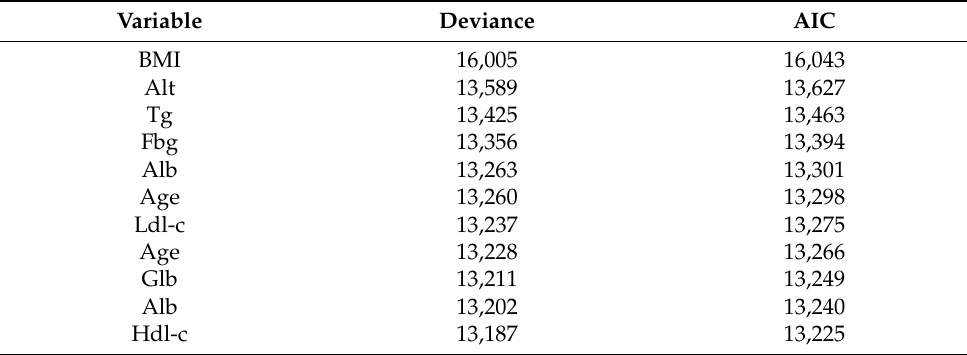
Table 2. Feature Selection Based on Akaike Information